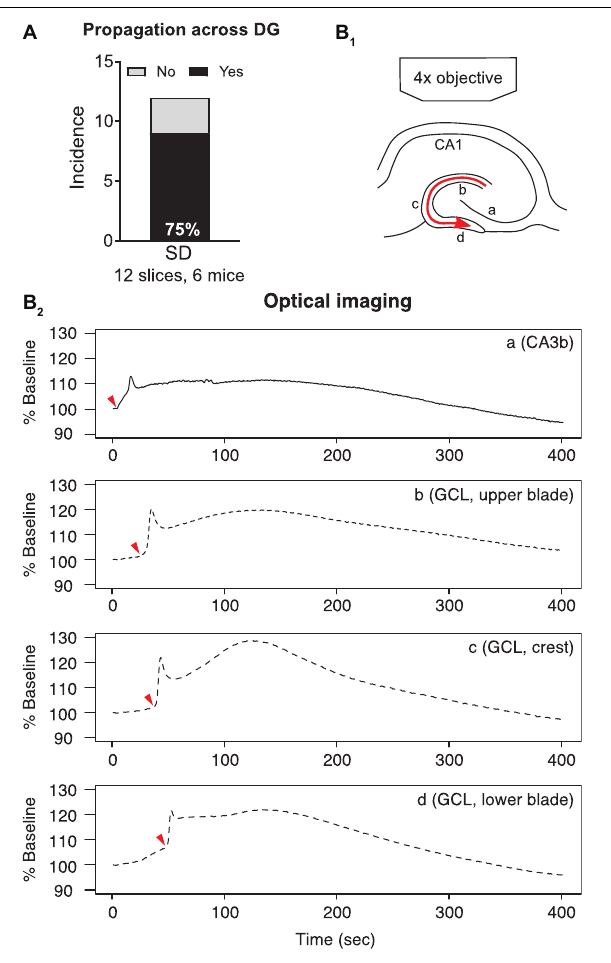
FIGURE 5 | Propagation of SD within the dentate gyrus. (A) SD that propagated from upper to lower blades occurred in the majority (77.8%) of optically recorded slices. (B1) A schematic of SD propagation. The red arrow indicates the observed direction of SD propagation. (B2) Representative traces of light changes in CA3b (a), GCL, upper blade (b), GCL, crest (c), and GCL, lower blade (d). Red arrowheads indicate the time when light transmission began the most rapid change, and shows the propagation of SD schematized in (B1)